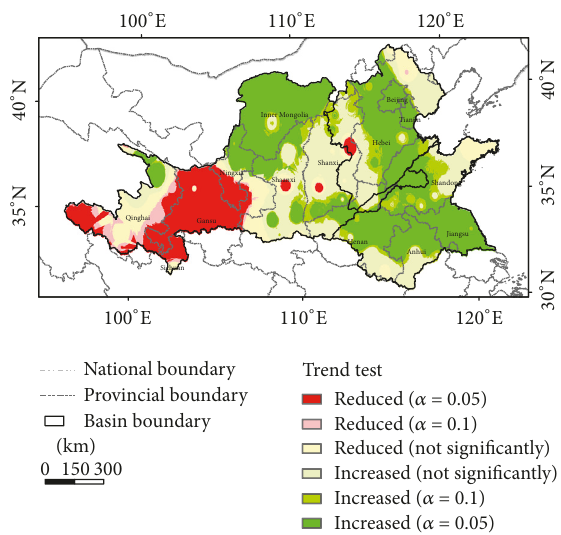
Figure 3: Trend test of the WYC trend from 1961 to 2011.